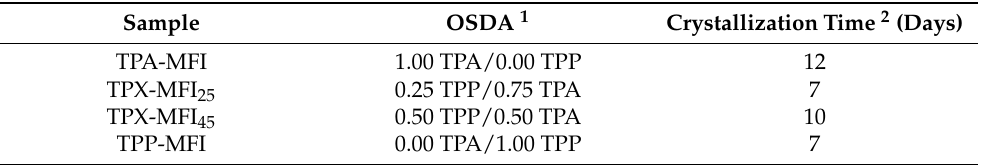
Table 1. Detailed synthesis conditions of the silicalite-1 samples prepared using TPA, TPP, and mixtures of them as